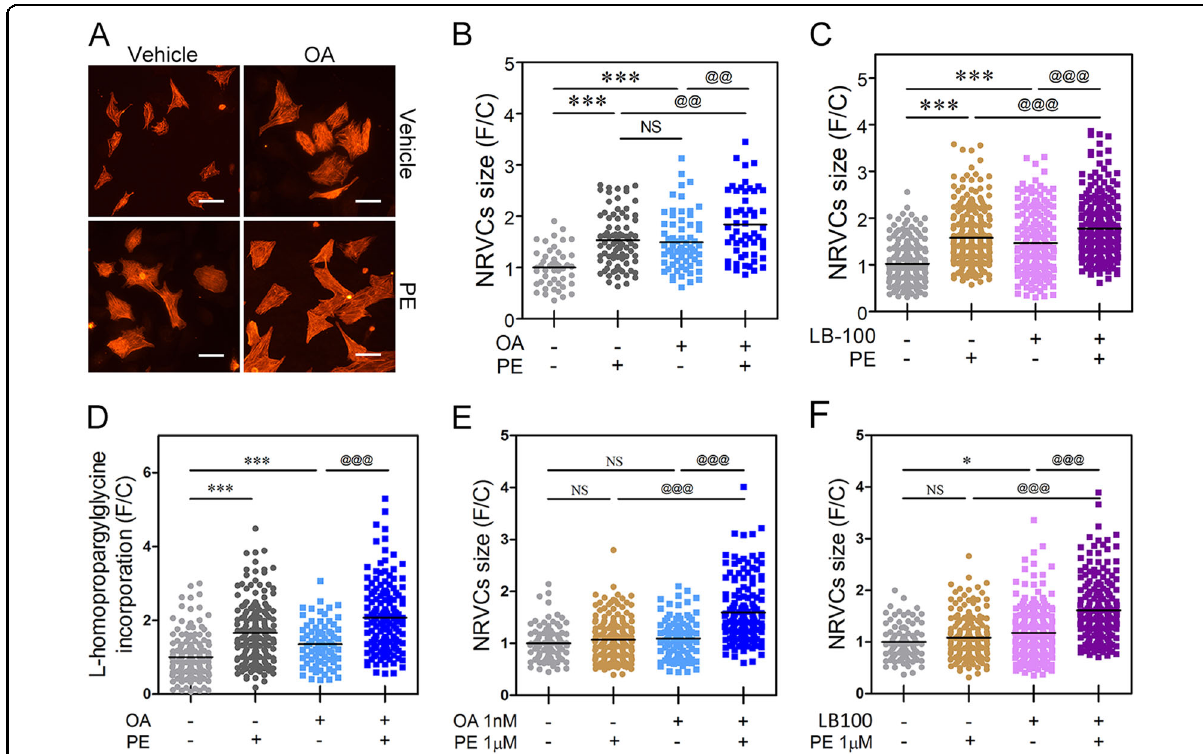
Fig. 5 PP2A inhibitor augments the hypertrophic response. a – d PP2A selective inhibitors successfully induced cardiomyocyte hypertrophy. a , b OA itself signi fi cantly induced cardiomyocyte enlargement, which was further potentiated by 20 μ mol/L PE. c LB-100, an alternative PP2A inhibitor, also provoked cardiomyocyte hypertrophy, and this effect was further exaggerated by 20 μ mol/L PE. d Measurement of de novo protein synthesis by use of the L -homopropargylglycine (HPG) assay. The PP2A selective inhibitor, OA, induced cardiomyocyte hypertrophy, which was further potentiated by exposure to 20 μ mol/L phenylephrine (PE). e , f A low dose of PE, which failed to induce hypertrophy itself, also